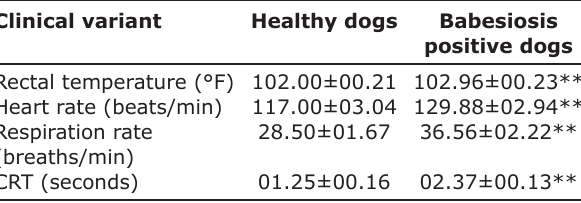
Table-1: Clinical variants (mean±SE values) in healthy and babesiosis positive dogs. Clinical variant